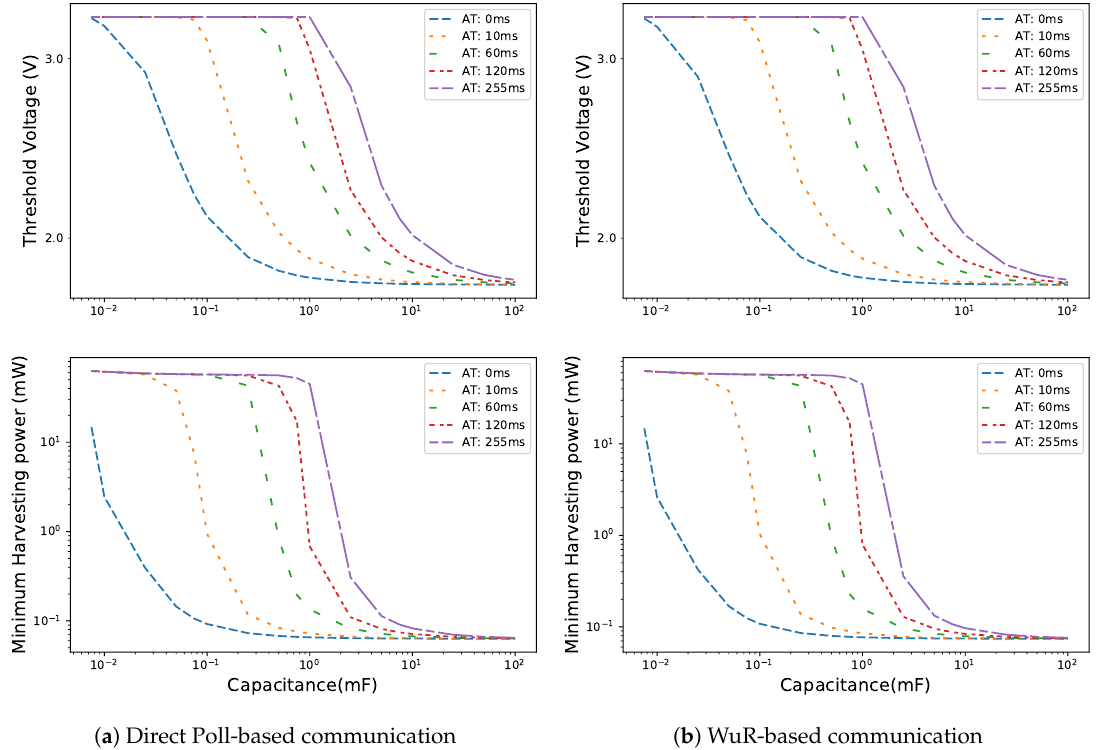
Figure 9. Threshold voltage and minimum harvesting power for different arrival times